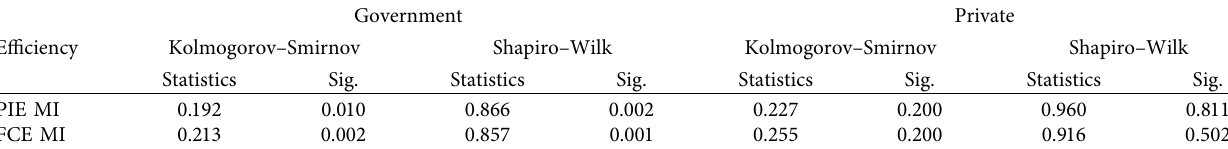
Table 9: Normality tests for the Malmquist Indexes.